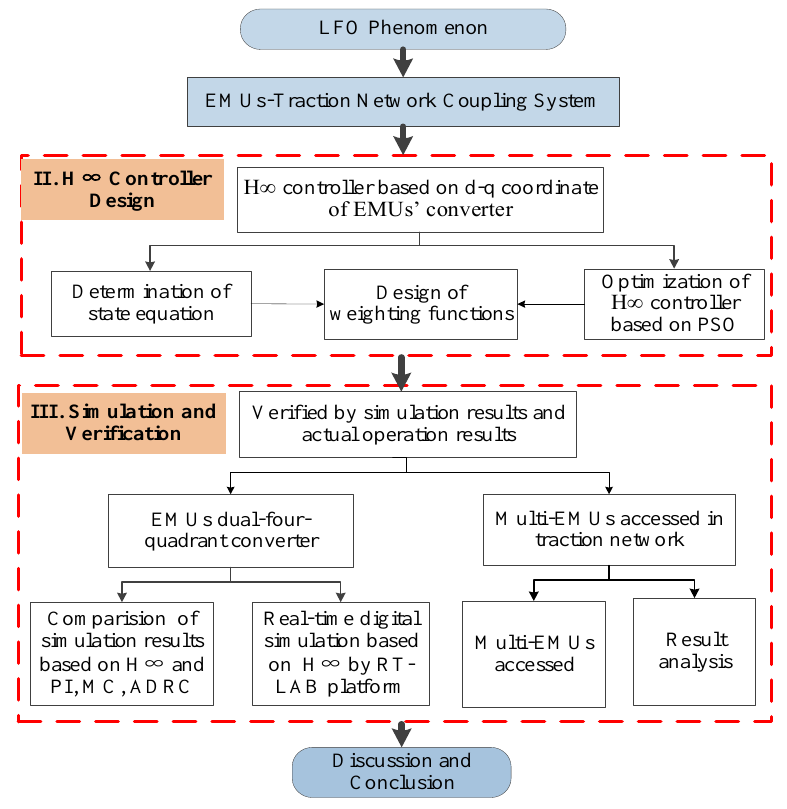
Figure 2. The idea in this paper. LFO: low-frequency oscillation; PSO: particle swarm optimization; PI: proportional integral; MC: multivariable control; ADRC: auto-disturbance rejection control.